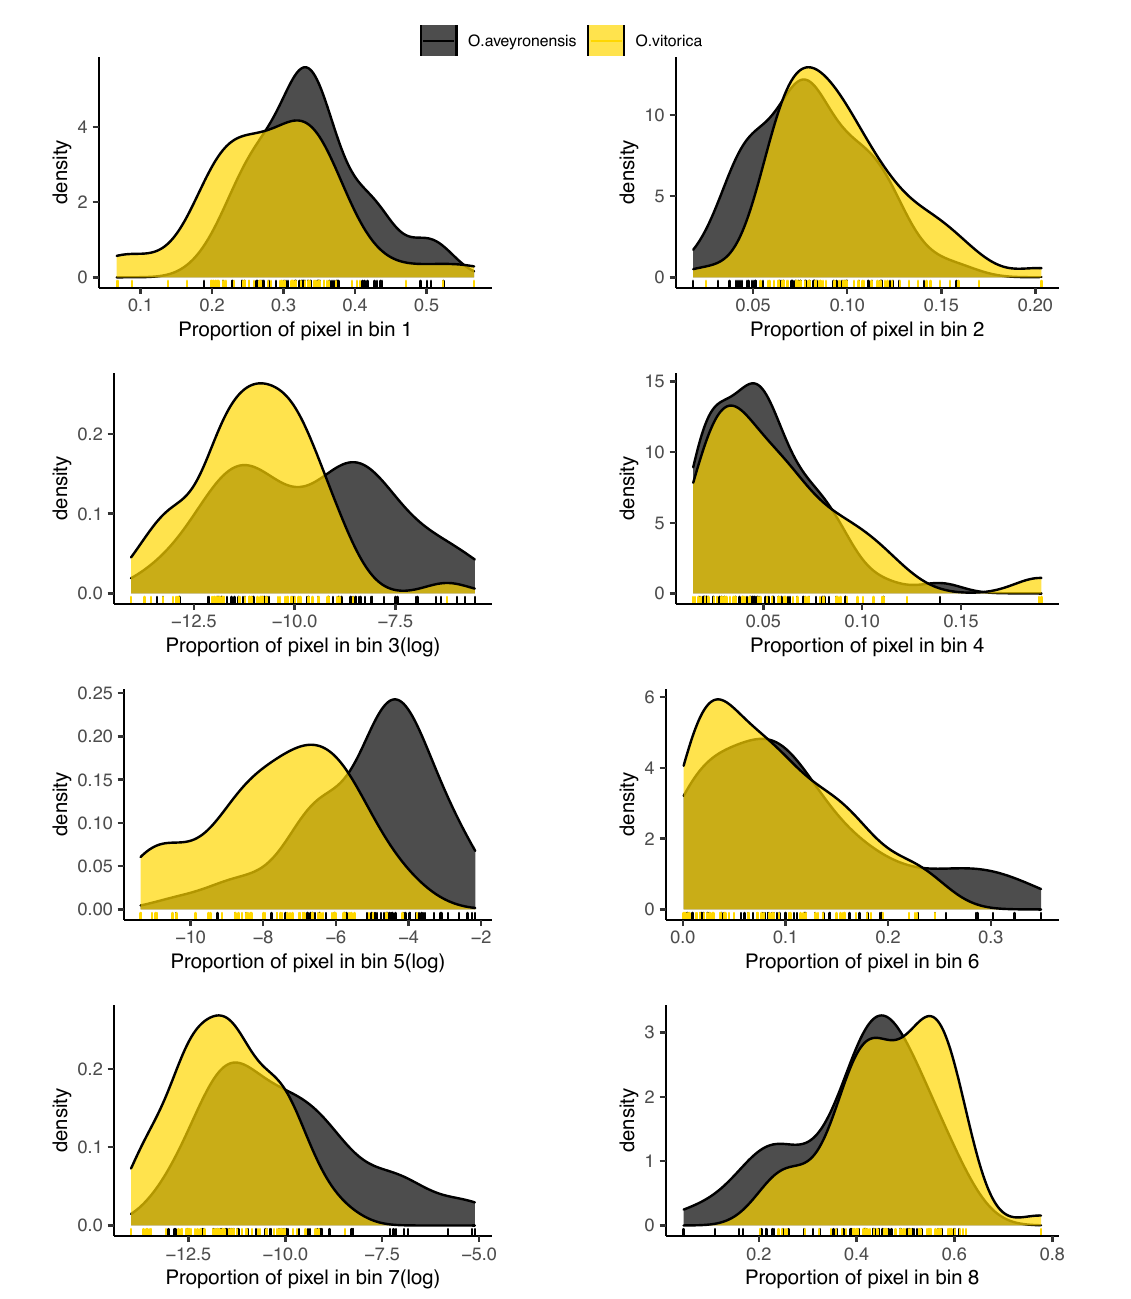
Figure A3. Distribution of colour traits for O. a. subsp. aveyronensis and O. aveyronensis subsp. vitorica